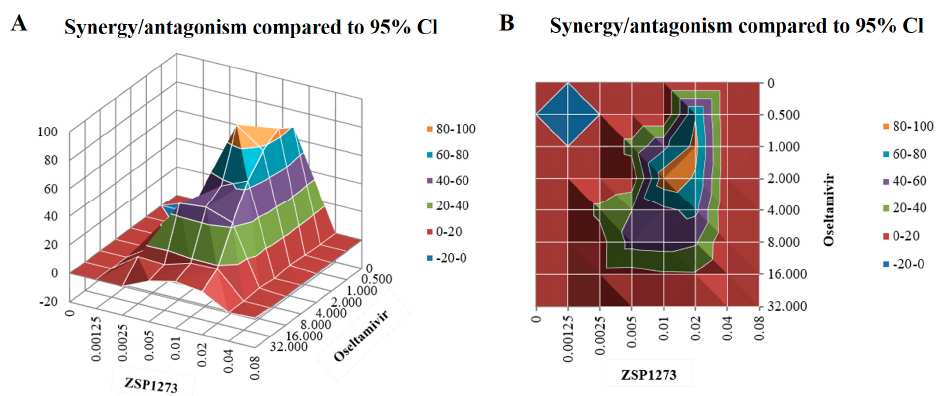
Figure 3. Efficacy of ZSP1273 in combination with oseltamivir in vitro: ( A ) Positive and negative synergy diagrams of the combined administration. A positive combined index indicates a synergistic effect, while a negative combined index indicates an antagonistic effect. If the absolute value of the index is <25, it indicates an additive effect; if the above value is in the range of 25–50, it indicates a mild but clear synergistic or antagonistic effect; if the above value is in the range of 50–100, it indicates a moderate synergistic or antagonistic effect, which is possibly important for in vivo effects; if the above value is >100, it indicates a high degree of synergistic or antagonistic effect, which is probably important for in vivo effects. ( B ) An aerial view of ( A ).